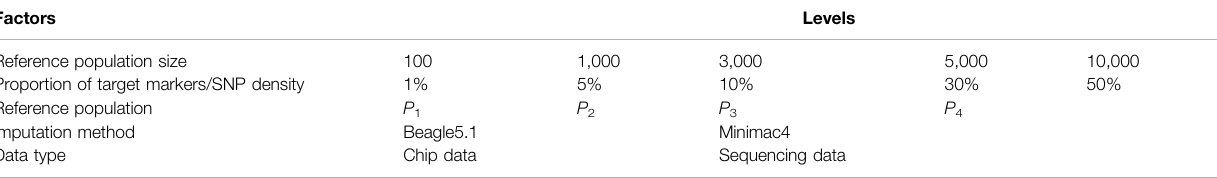
TABLE 3 | Levels of each factor to de fi ne the imputation scenarios.